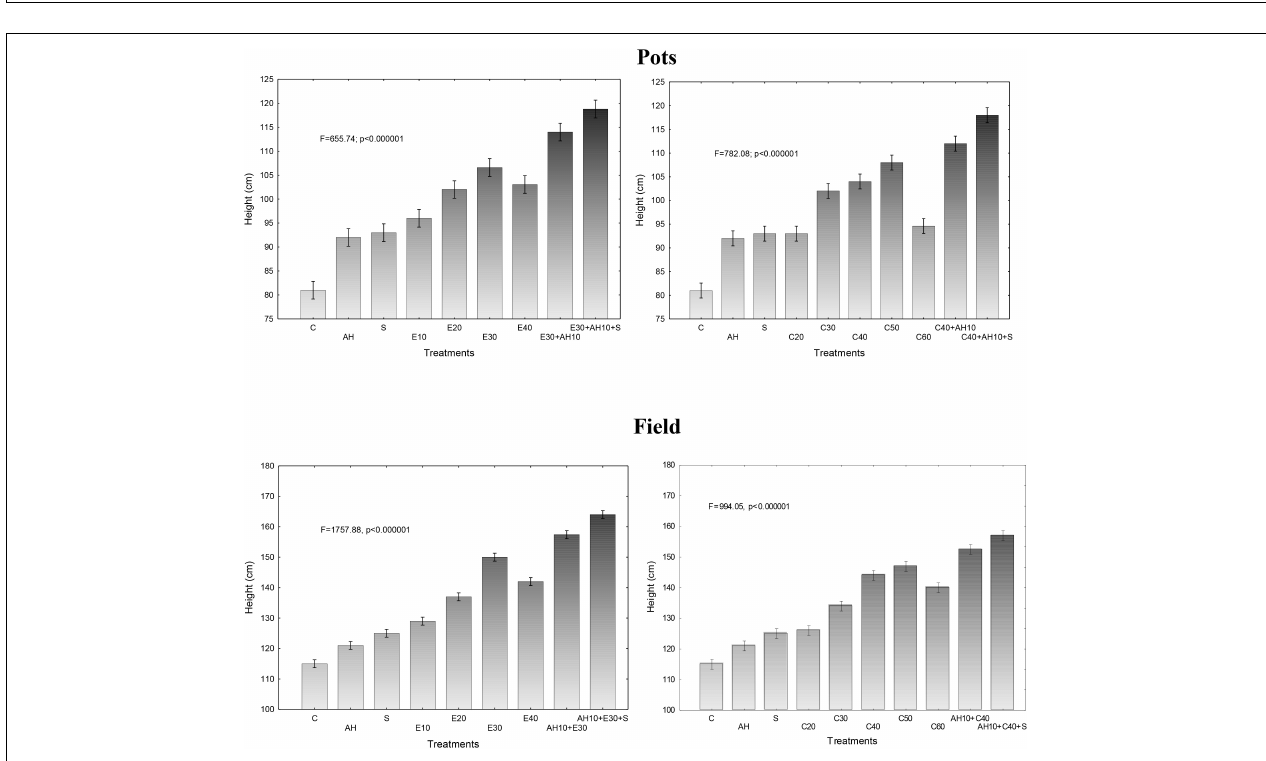
FIGURE 2 | Final height of sorghum plants cultivated in pots and field and fertilized with liquid waste from a biomass biodigestion to methane, non-centrifuged (E 10–40 m 3 ha − 1 ) and centrifuged (C 20–60 m 3 ha − 1 ), Apol-humus (AH; 10 L ha − 1 ) and Stymjod ( (S; 5 L ha − 1 ).